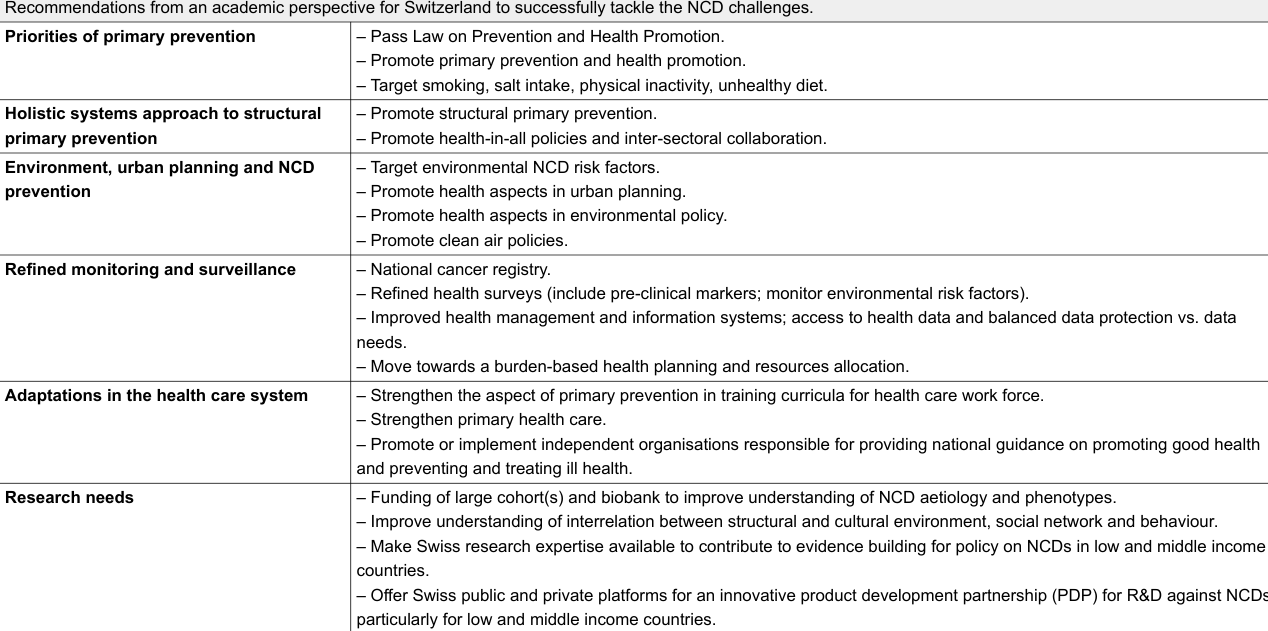
Table 2: Recommendations from an academic perspective for Switzerland to successfully tackle the NCD